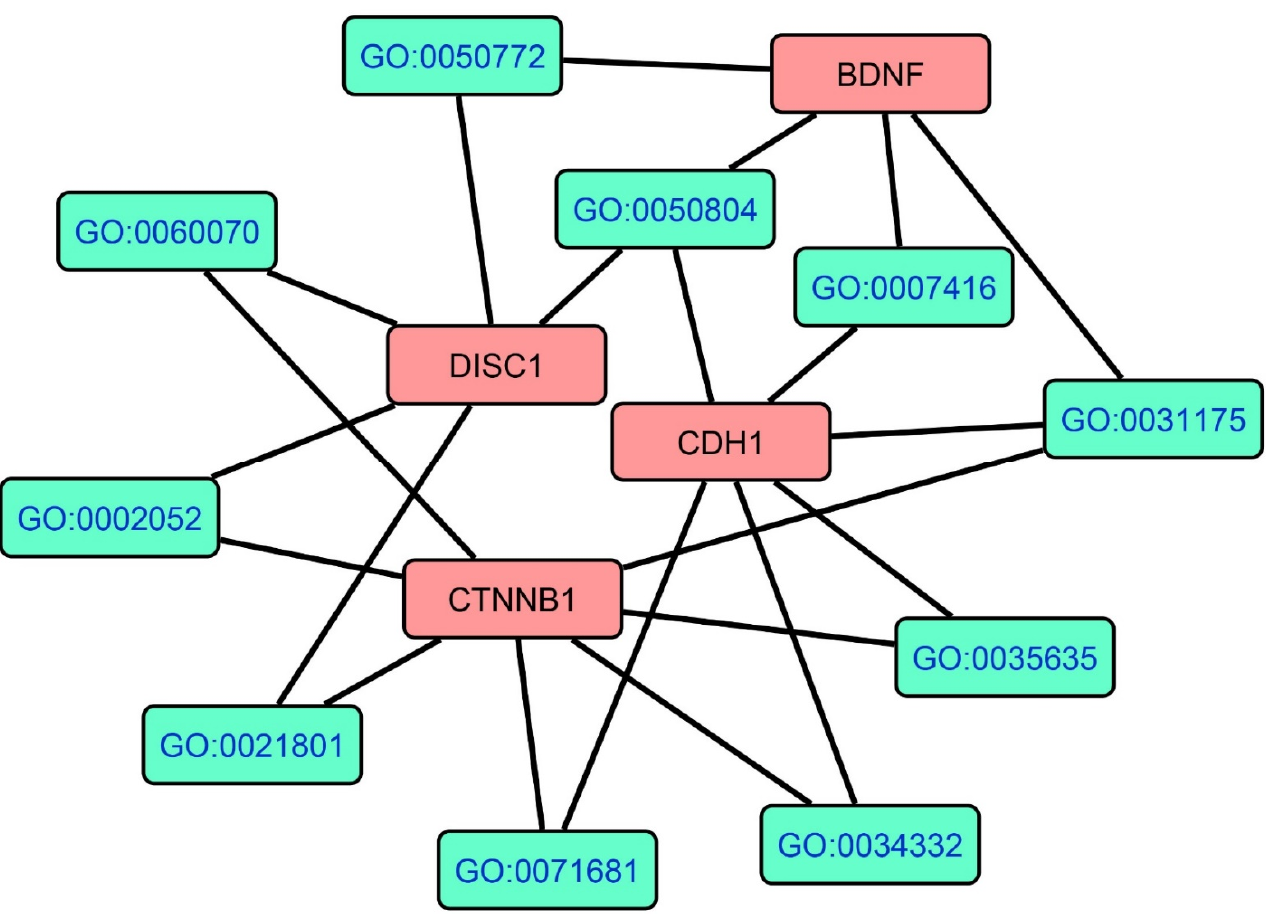
Figure 7. Results of GOnet annotation visualization in FEP/FES depicting the hierarchical structure of GO terms and the downregulated genes. This figure shows the seed protein nodes and the top 10 GO terms (i.e., their most important chil- dren).